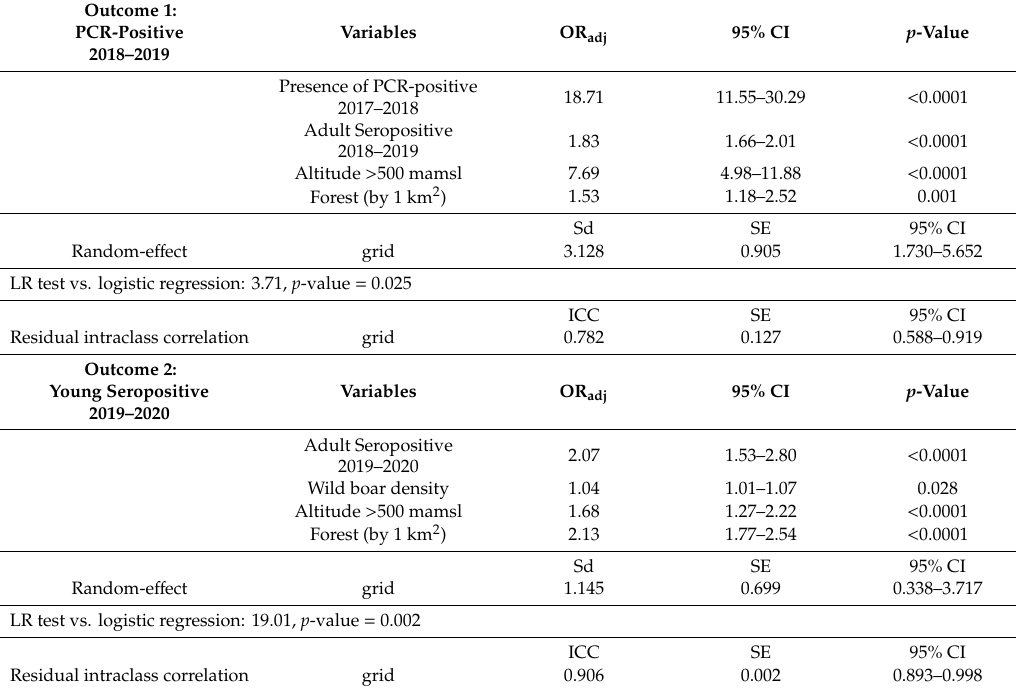
Table 3. Results of the mixed-e ff ect logistic regression model with ( a ) PCR-positive cases